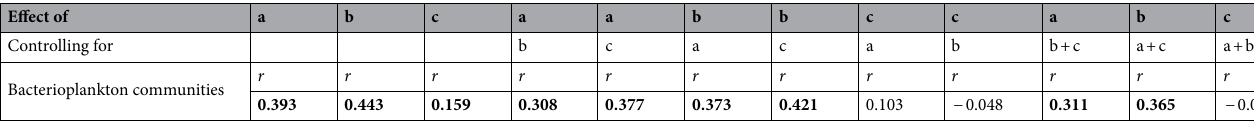
Table 2. The influences of karst level, trophic status and hydrochemical factors on bacterioplankton communities by partial Mantel test. Bold indicates a significant correlation ( P < 0.05). a Karst level includes Ca 2+ , HCO 3− and EC. b Trophic status includes TN, TP, TOC, DOC, COD Mn and Chl a. c Hydrochemical factors includes WT, pH and DO.